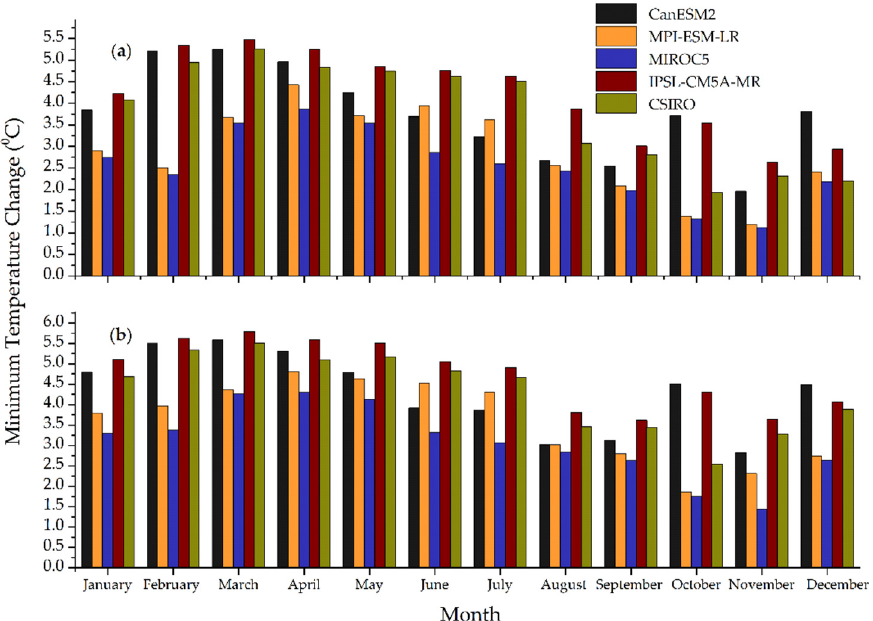
Figure 12. Changes in the monthly minimum temperature of the far future period from 2071–2100, with respect to the baseline obtained with: ( a ) RCP4.5; and ( b ) RCP8.5.